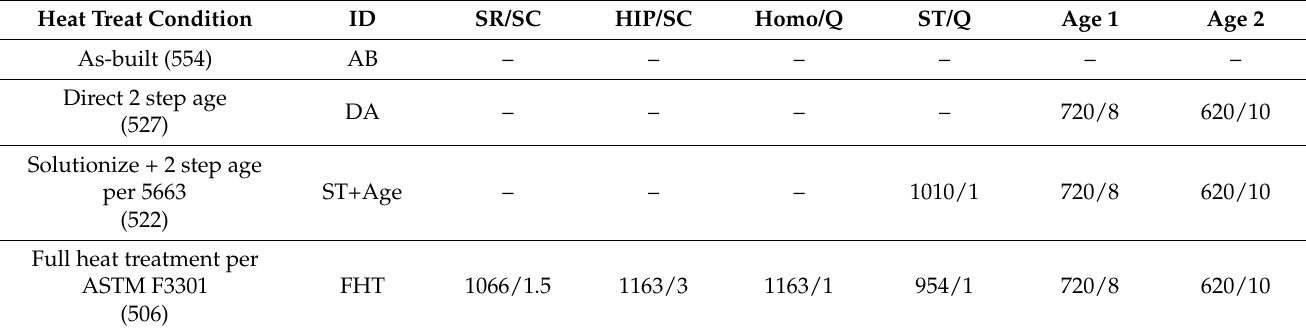
Table 2. Heat treatment conditions: temperature ( ◦ C) per time